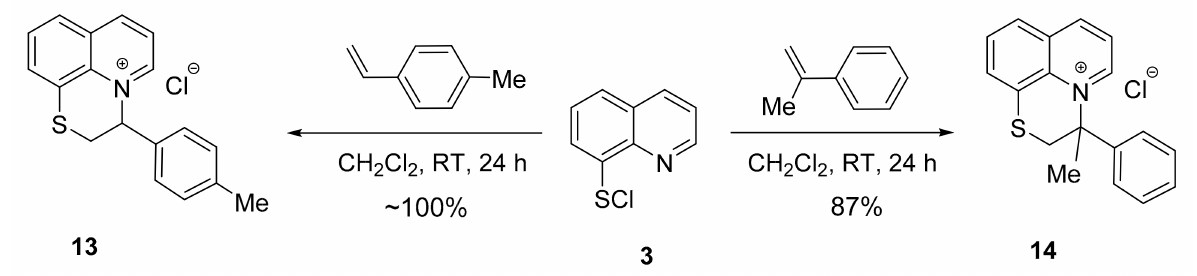
Scheme 7. Synthesis of compounds 13 and 14 by the annulation reactions of sulfenyl chloride 3 with 4-methylstyrene and α